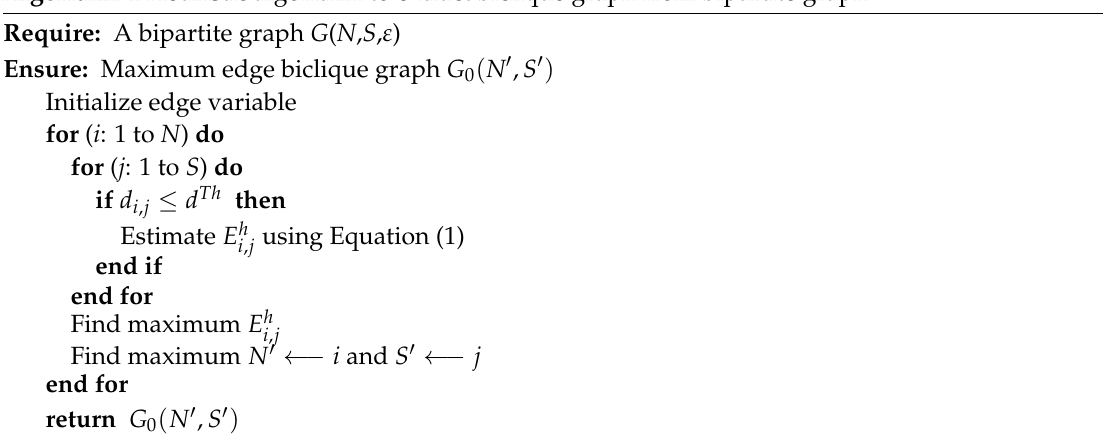
Algorithm 1 Heuristic algorithm to extract biclique graph from bipartite